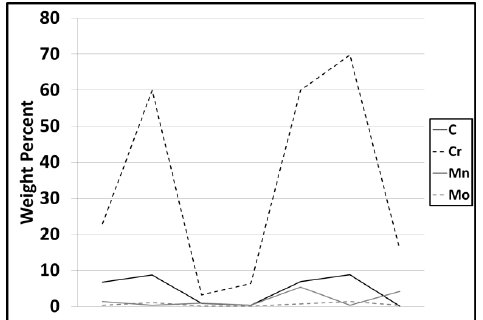
Figure 15. Diagram summarizing the chemical gradients that exist in cementite, M 7 C 3 carbide and austenite at T peak .